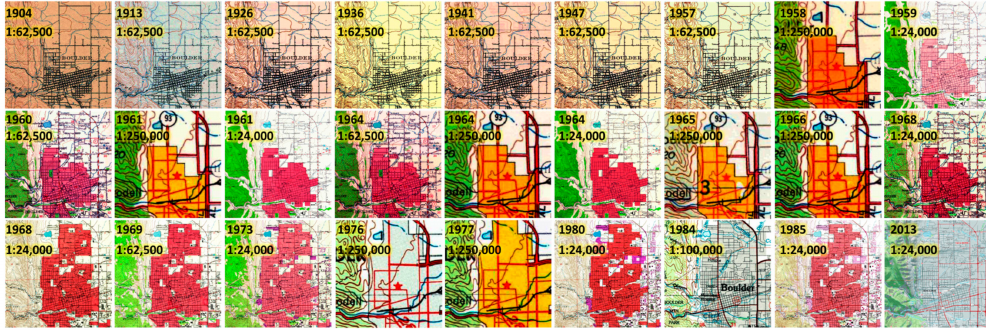
Figure 2. Available USGS topographic map sheets covering Boulder, Colorado (USA) from 1904 to 2013 at various map